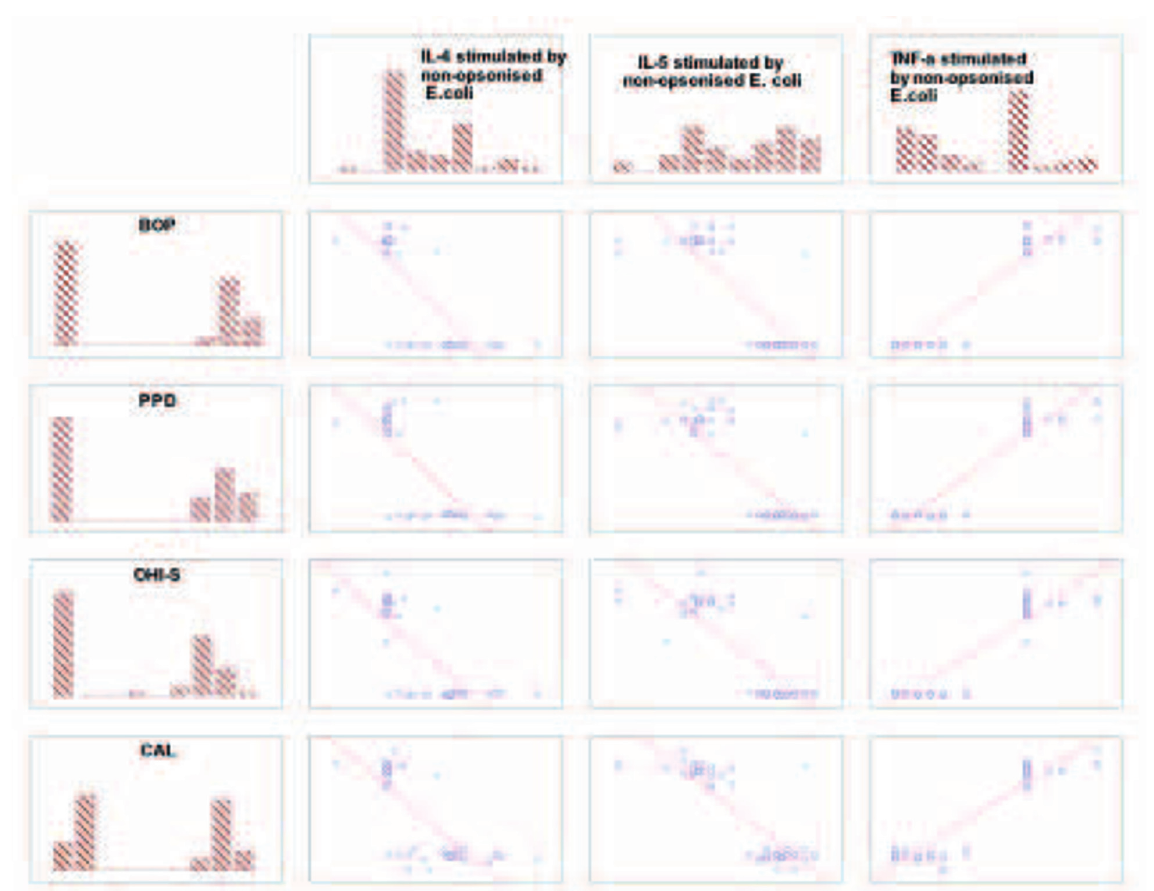
BOP-bleeding on probing , PPD–pocket probing depths (mm), OHI-S- simplifi ed Oral Hygiene Index, CAL- clinical attachment level Figure 2. Scatterplot matrix for all variables in correlation matrix. Data fi ting function–linear